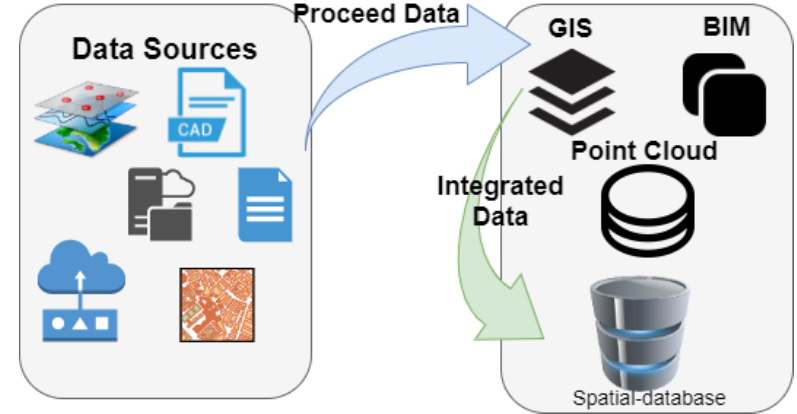
Figure 3. An integrated spatial